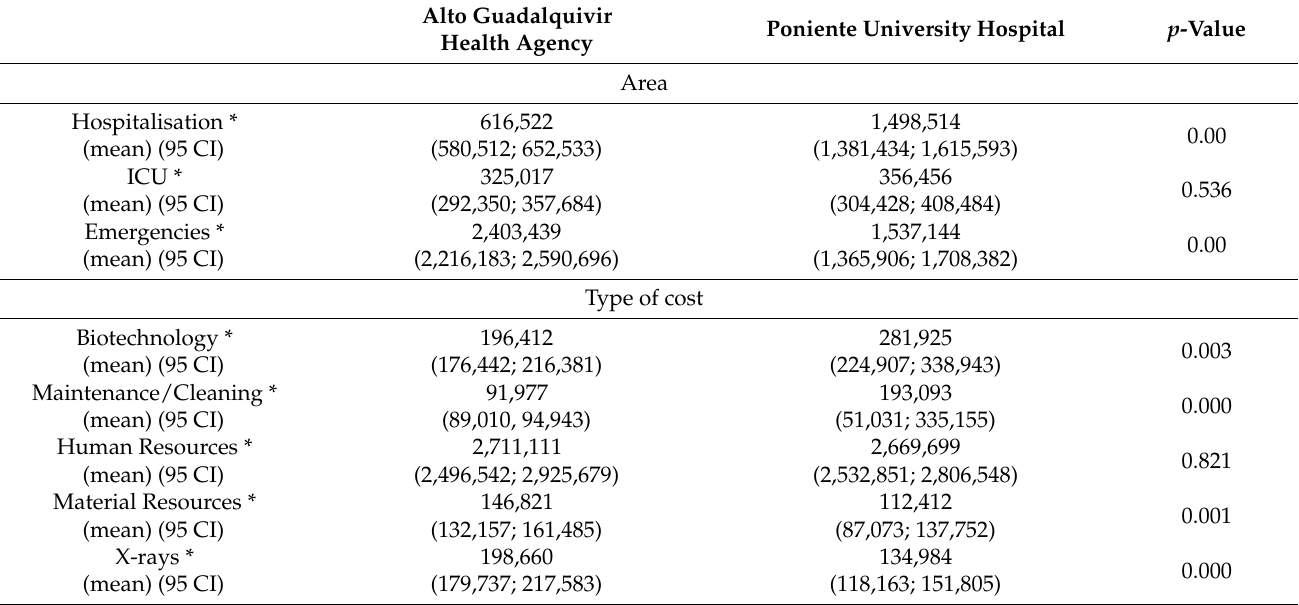
Table 4. Comparison of costs by year incurred by area and type of cost between the two regional hospitals. Alto Guadalquivir